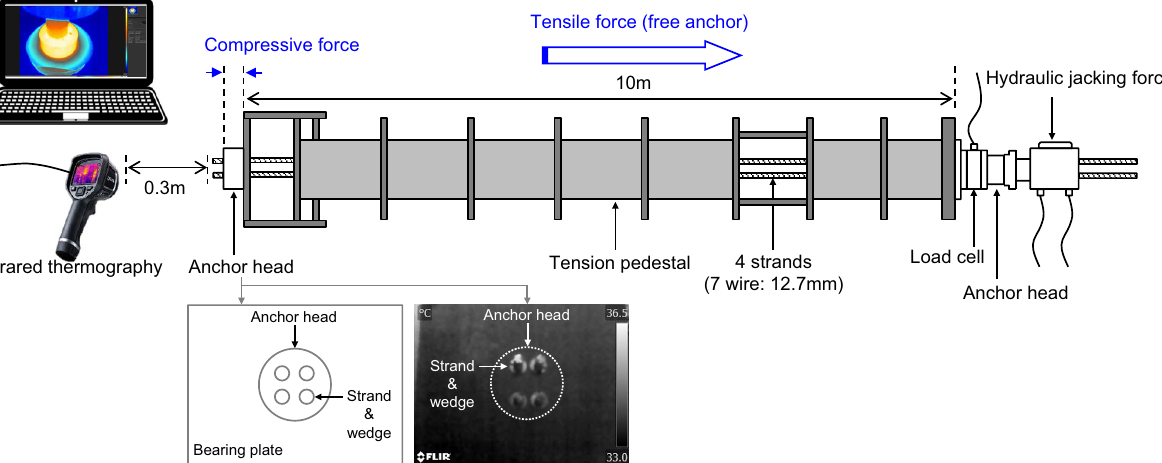
Figure 3. Ground anchor real scale infrared thermography experiment schematic.